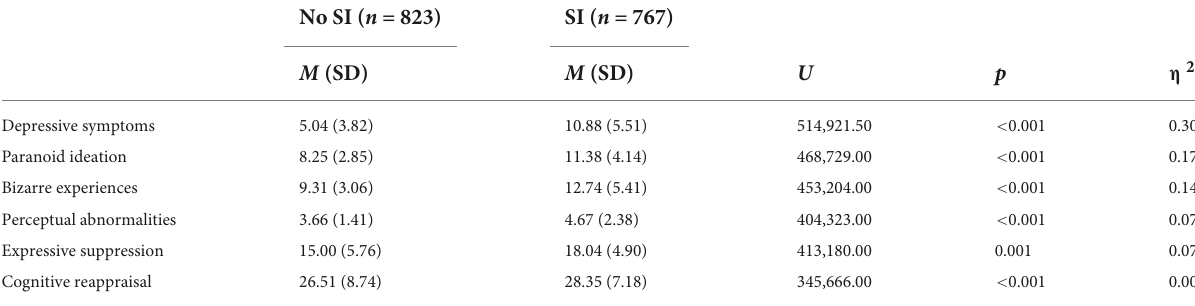
TABLE 1 Depression, psychotic experiences, and emotion regulation among adolescents with and without suicidal ideation.